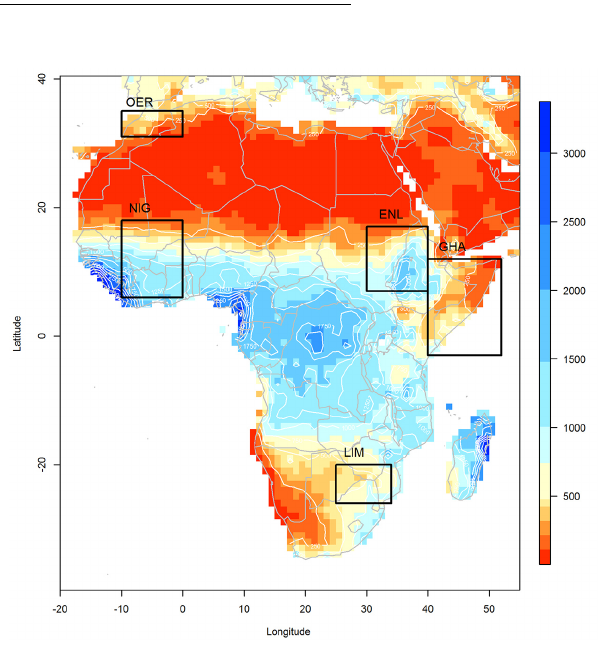
Fig. 1. Annual mean precipitation from the GPCC data set and African regions used in this analysis as defined in Table 1. OER: Oum er-Rbia; NIG: Inner Niger Delta; ENL: Eastern Nile, LIM: Limpopo Basin and GHA: Greater Horn of